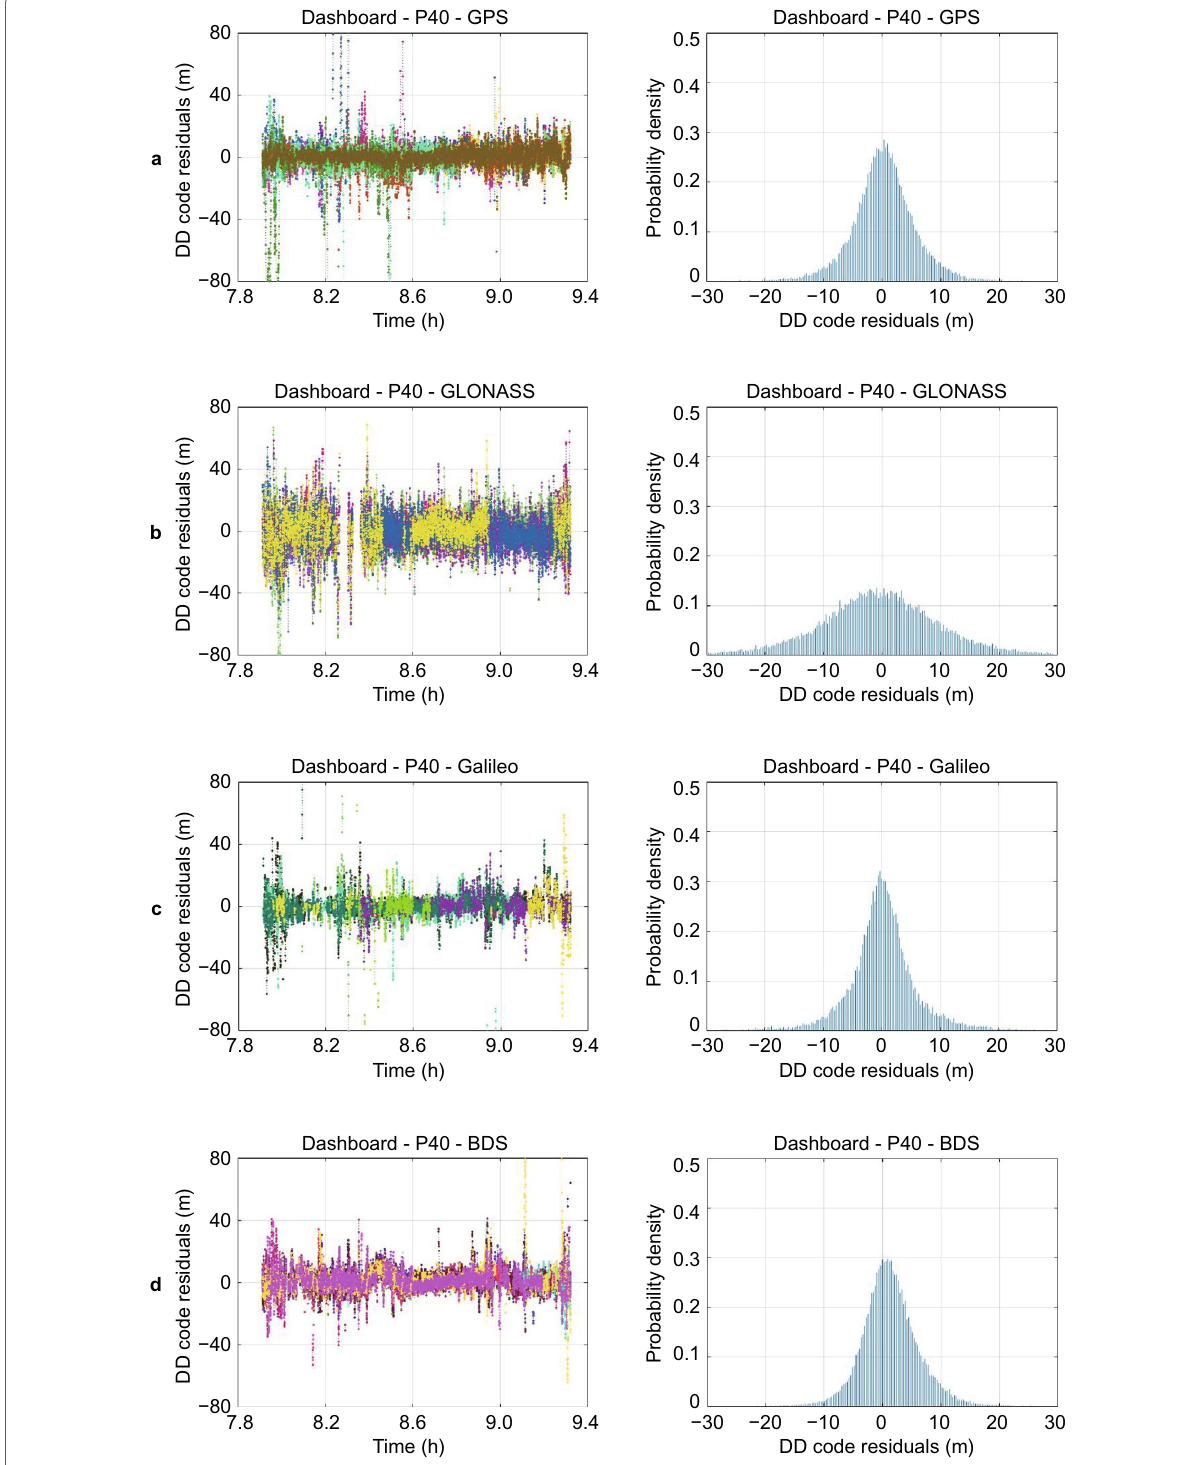
Fig. 5 Time series and probability density distribution of double-differenced (DD) code residuals on the first frequency band for the P40 smartphone in the vehicle-roof mode: a GPS L1, b GLONASS L1, c Galileo E1, and d BDS